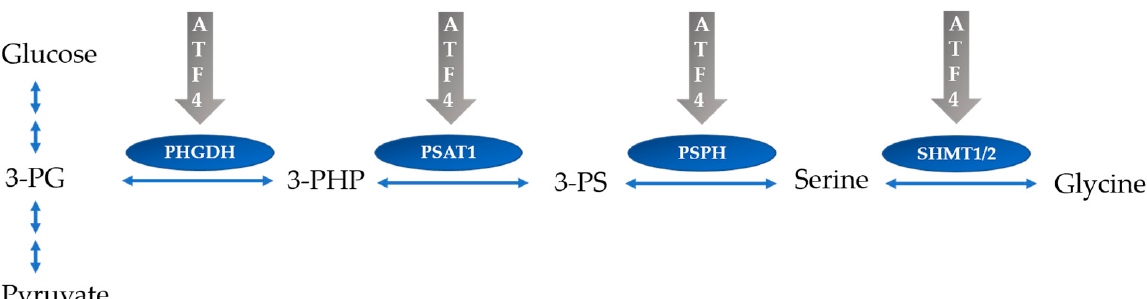
Figure 6. De novo serine–glycine biosynthesis. ATF4 leads to an increase in the expression of enzymes involved in serine–glycine synthesis. 3-PG is converted into serine and glycine by four enzymatic reactions. 3-PG (3-phosphoglycerate); PHGDH (phosphoglycerate dehydrogenase); 3- PHP phosphoserine); PSPH (phosphoserine phosphatase); SHMT1/2 (serine hydroxymethyltransferase 1/2).